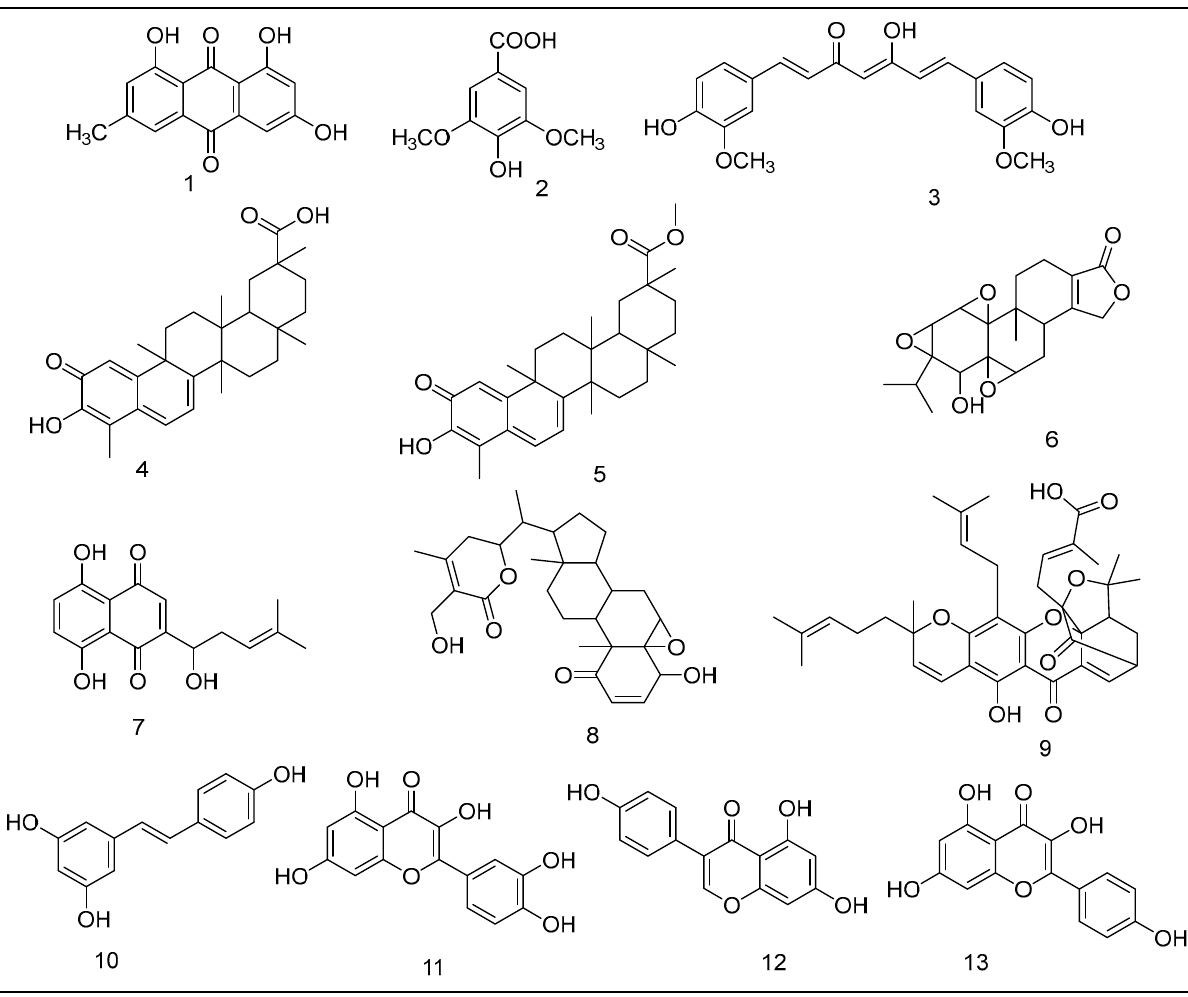
Figure 2. Plant-derived proteasome inhibitors: ( 1 ) emodin; ( 2 ) syringic acid; ( 3 ) curcumin; ( 4 ) celastrol; ( 5 ) pristimerin; ( 6 ) triptolide; ( 7 ) shikonin; ( 8 ) withaferin A; ( 9 ) gambogic acid; ( 10 ) resveratrol; ( 11 ) quercetin; ( 12 ) genistein; ( 13 )